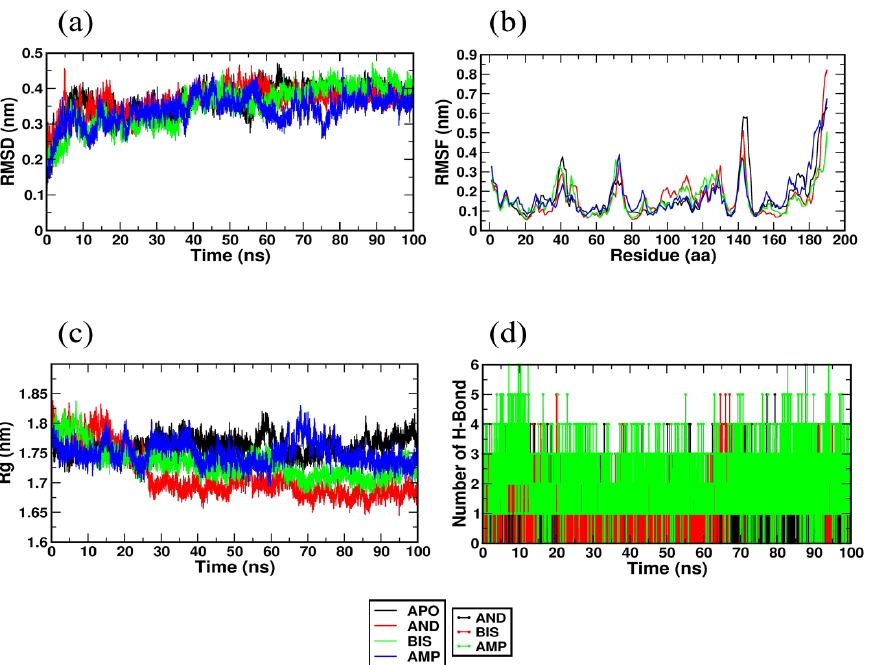
Figure 5. ( a ) Root means square deviation of atoms of Apo and protein-ligand complex (Bisandro- grapholide and Andrographiside). ( b ) Root means square fluctuation of atoms of Apo protein and its complex with Bisandrographolide and Andrographiside. ( c ) Radius of gyration (RG) of Apo protein and its complex with Bisandrographolide and Andrographoside. ( d ) Hydrogen bond of the complex with Bisandrographolide and Andrographiside.